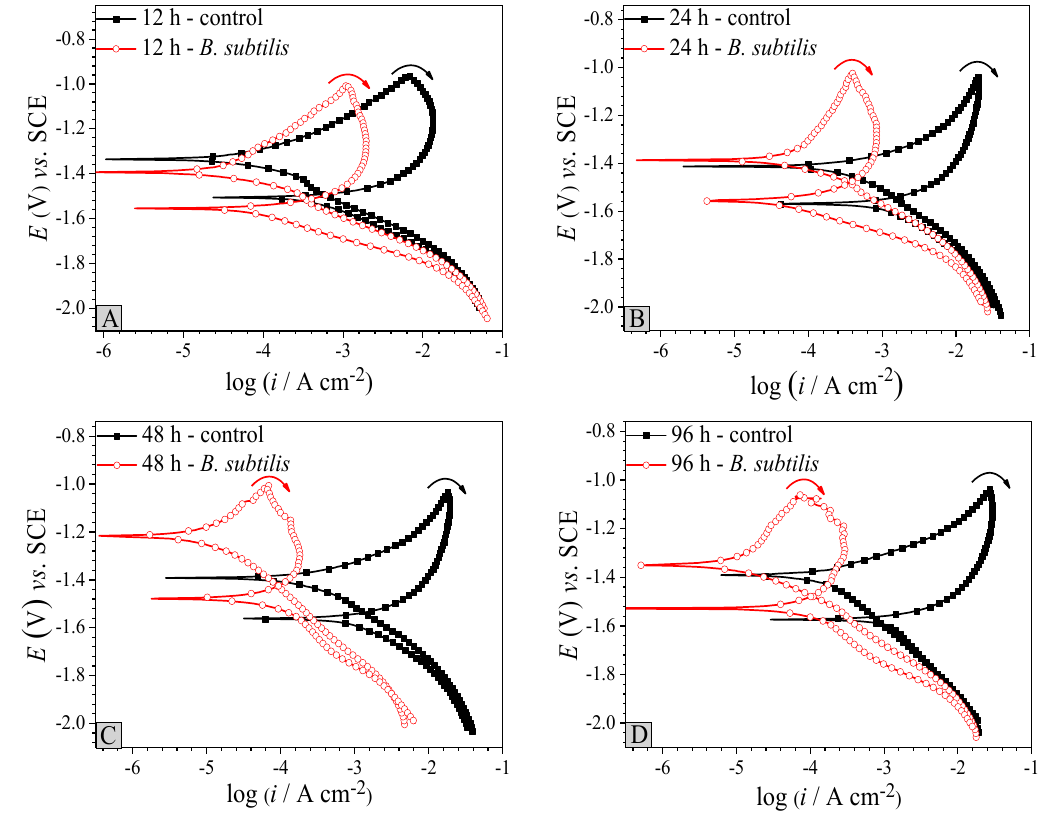
Figure 4. Cyclic polarization curves with immersion time of AZ31B magnesium alloy coupons in the control group and the B. subtilis presence group. ( A ) 12 h; ( B ) 24 h; ( C ) 48 h; ( D ) 96 h.